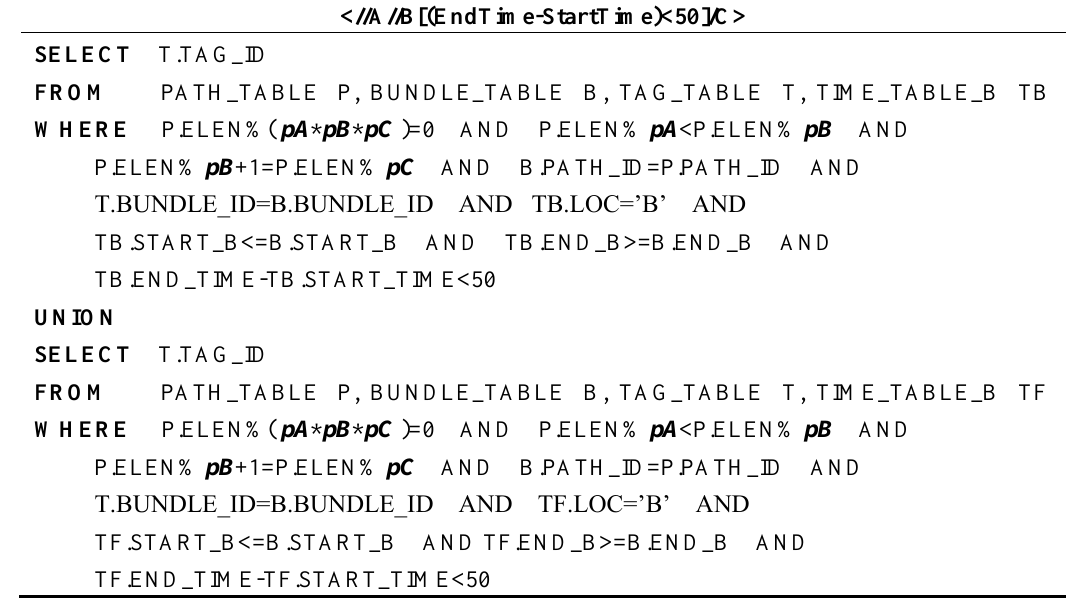
Table 8. SQL statements of